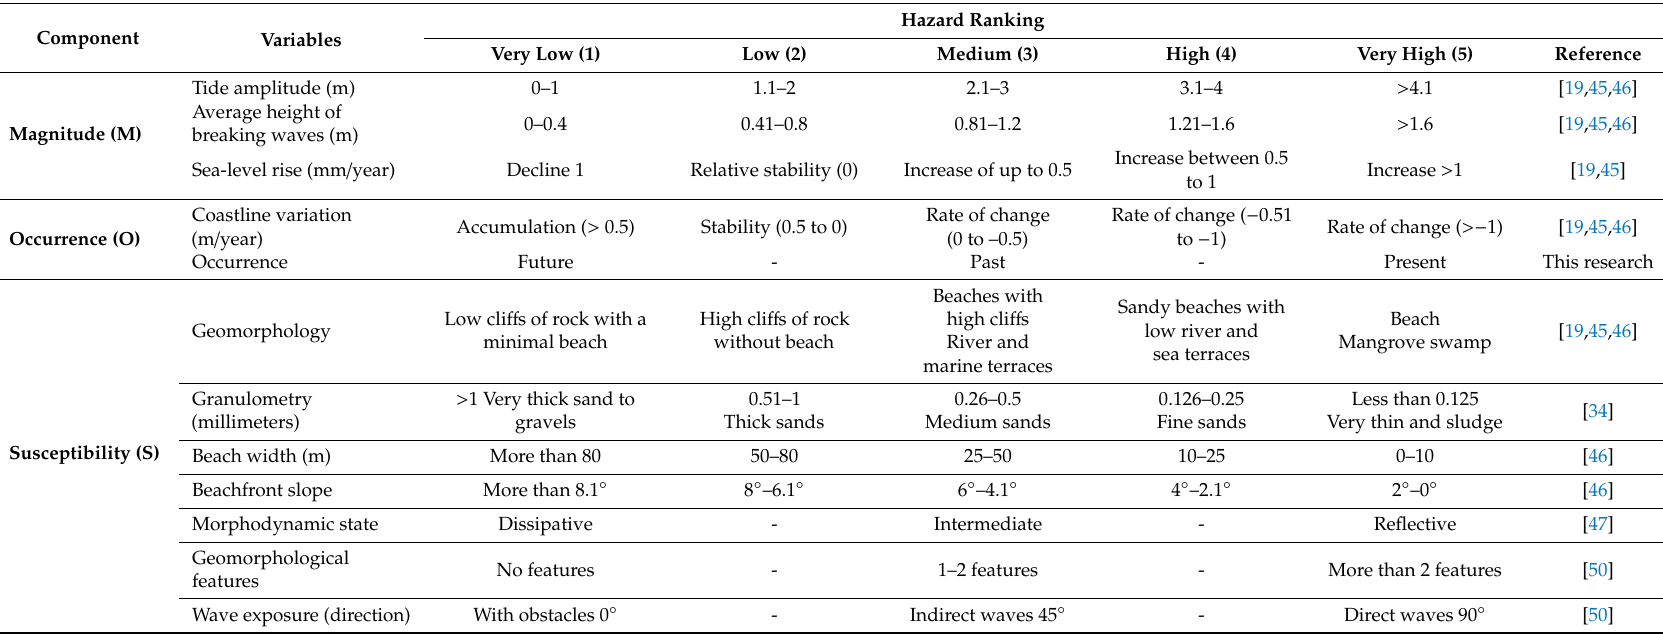
Table 1. List of variables per component considered in the hazard assessment and ranking